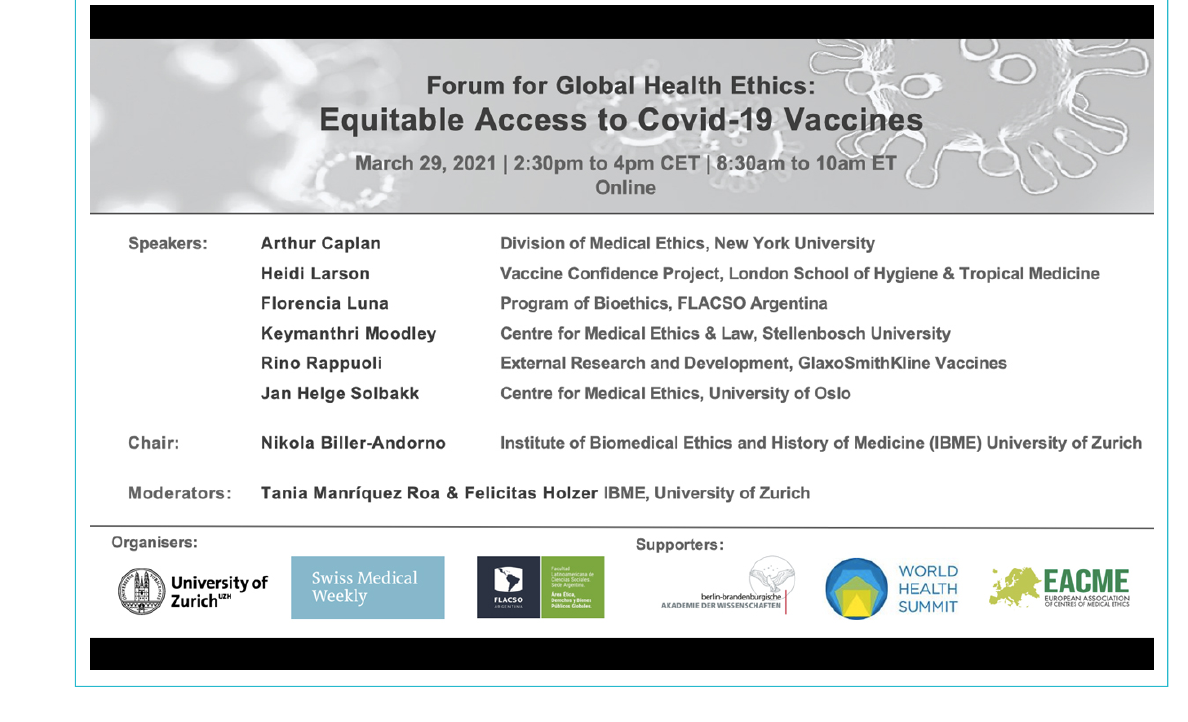
Figure 3: Invitation to the Forum for Global Health Ethics: Equitable Access to COVID-19 Vaccines (online event ‒ click here to join the event, password 621417. No registration